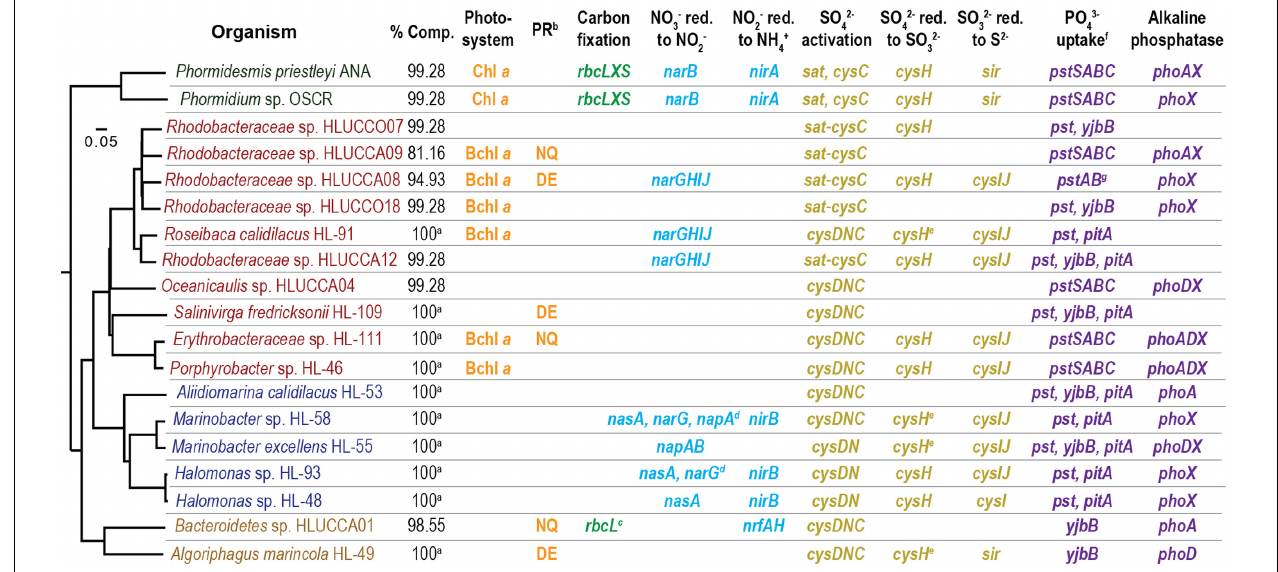
FIGURE 1 | Macronutrient acquisition functions detected in phototrophic consortium member genomes. Isolates belonging to the Cyanobacteria are green, Alphaproteobacteria are red, Gammaproteobacteria are blue, and Bacteroidetes are yellow. a Genomic information derived from sequenced isolates. b For description of the types of proteorhodopsins, see Supplementary Notes 2. c Similar to form IV RuBisCo, and thus unlikely to permit autotrophy (Supplementary Notes 3). d These organisms contain multiple complete nitrate reductases; only one gene of each type of multi-subunit nitrate reductase is denoted to conserve space. e Where organisms have multiple phosphate-acquisition systems, pst denotes the presence of pstSABC . f The pstAB genes are contiguous to a contig edge in the Rhodobacteraceae sp. HLUCCA08 reconstruction; pstSC are assumed to be within the gap between